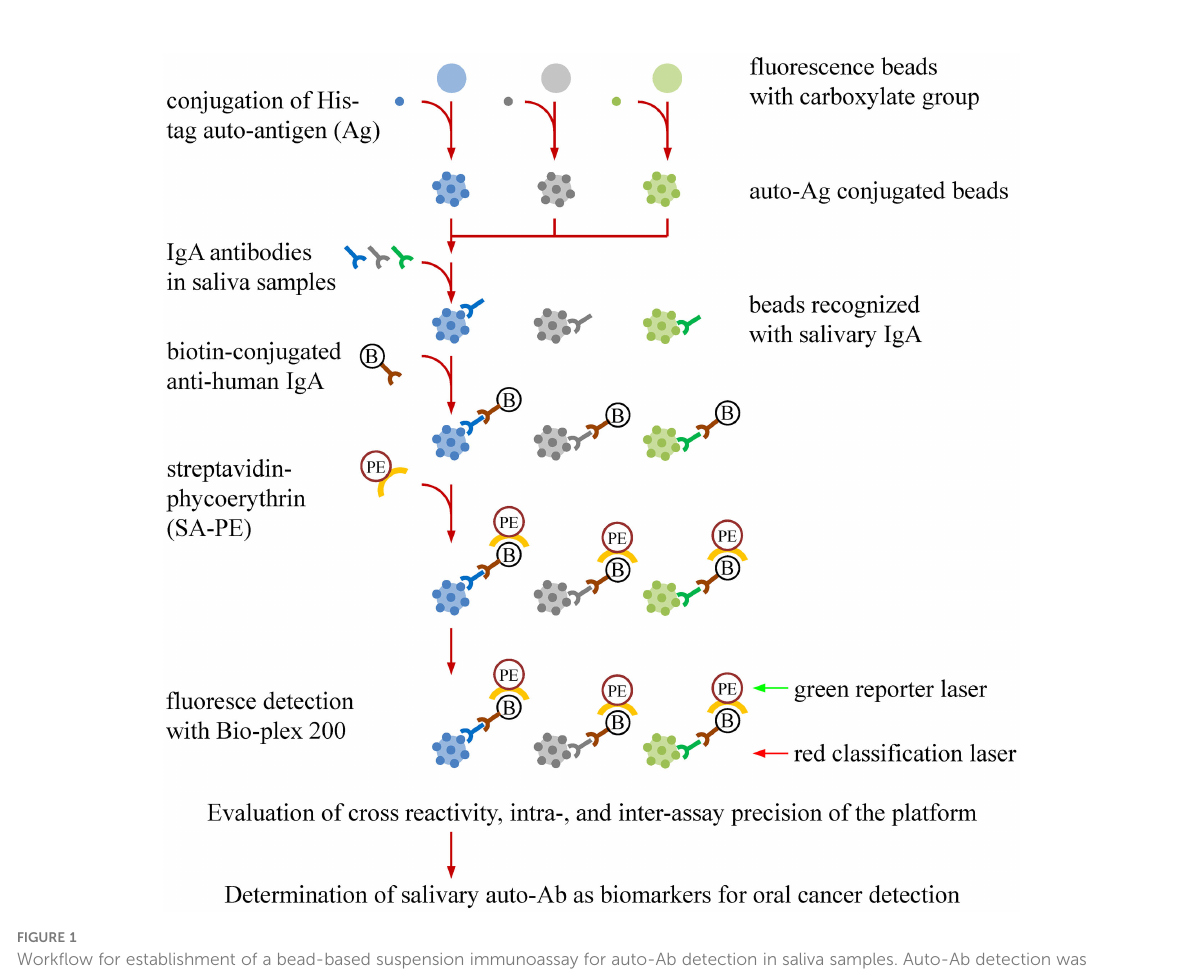
(Supplementary Table S2). Diagnostic accuracy of the auto-Abs was further determined by calculating their sensitivities (true positive rates). With a cut-off point of 90% speci fi city (true negative rate), the sensitivity of anti-p53 as an OSCC screening biomarker was 25.0%. Sensitivities of the other nine auto-Abs ranged between 28.8% and 46.3% (Table 3), all of which were superior to that of anti-p53. Notably, the sensitivities of anti- MMP3, anti-PRDX2, anti-SPARC, and anti-HSPA5 were more than 40%. Most importantly, using a marker panel composed of these four auto-Abs greatly improved the sensitivity of OSCC diagnosis (63.8%) compared with using the individual marker alone (Table 3). For distinguishing the OSCC patients from the healthy controls, the AUC value of using the four-auto-Ab panel was greater than that of using either marker alone (AUC = 0.806;